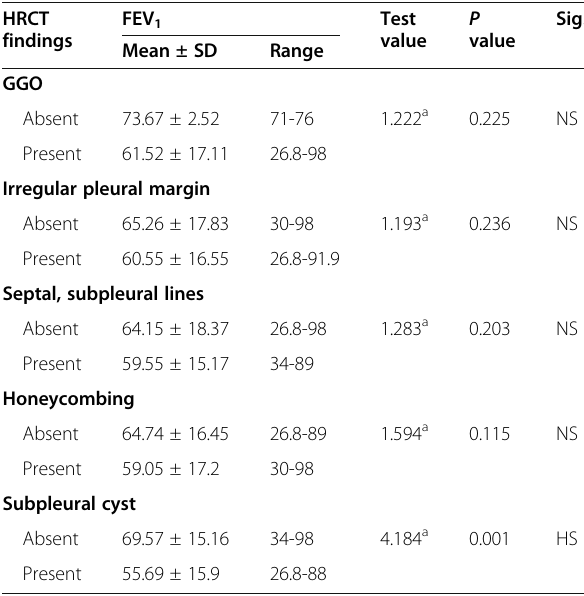
Table 7 Correlation between forced expiratory volume in the first second and Warrick ’ s score indices